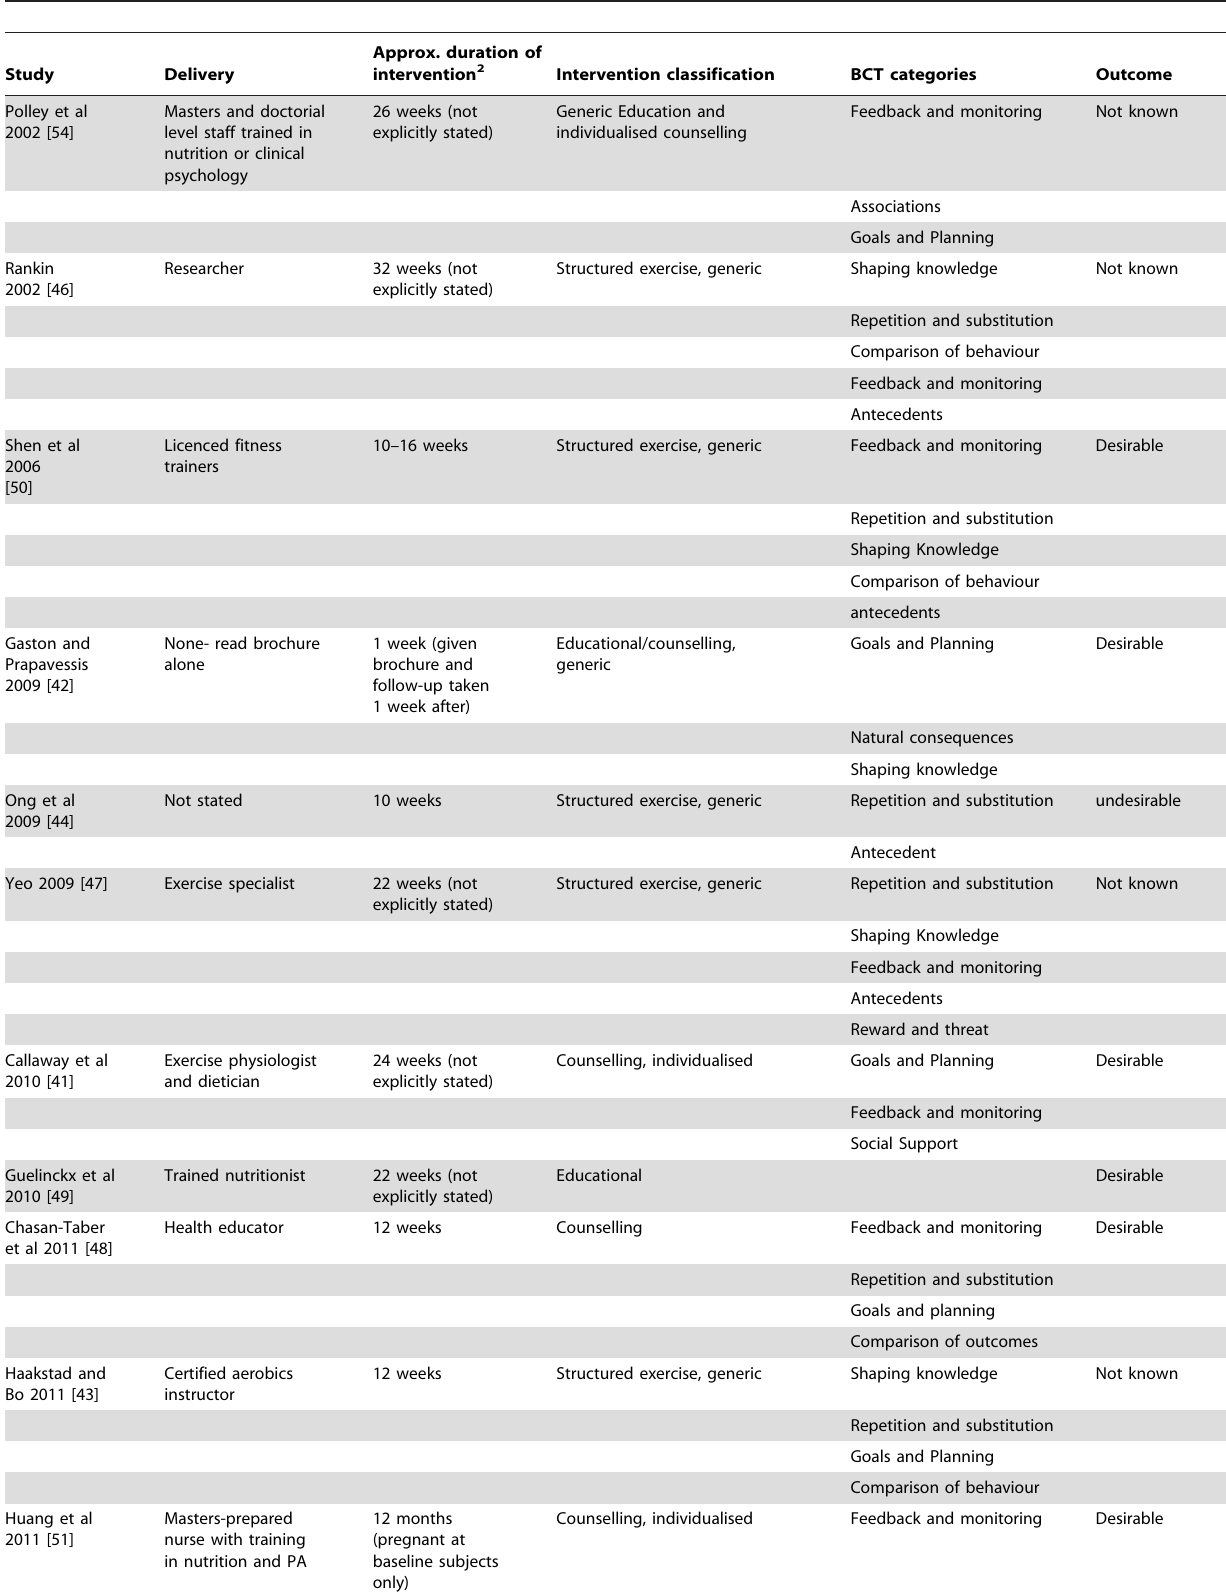
Table 3. Intervention components and BCTs employed.